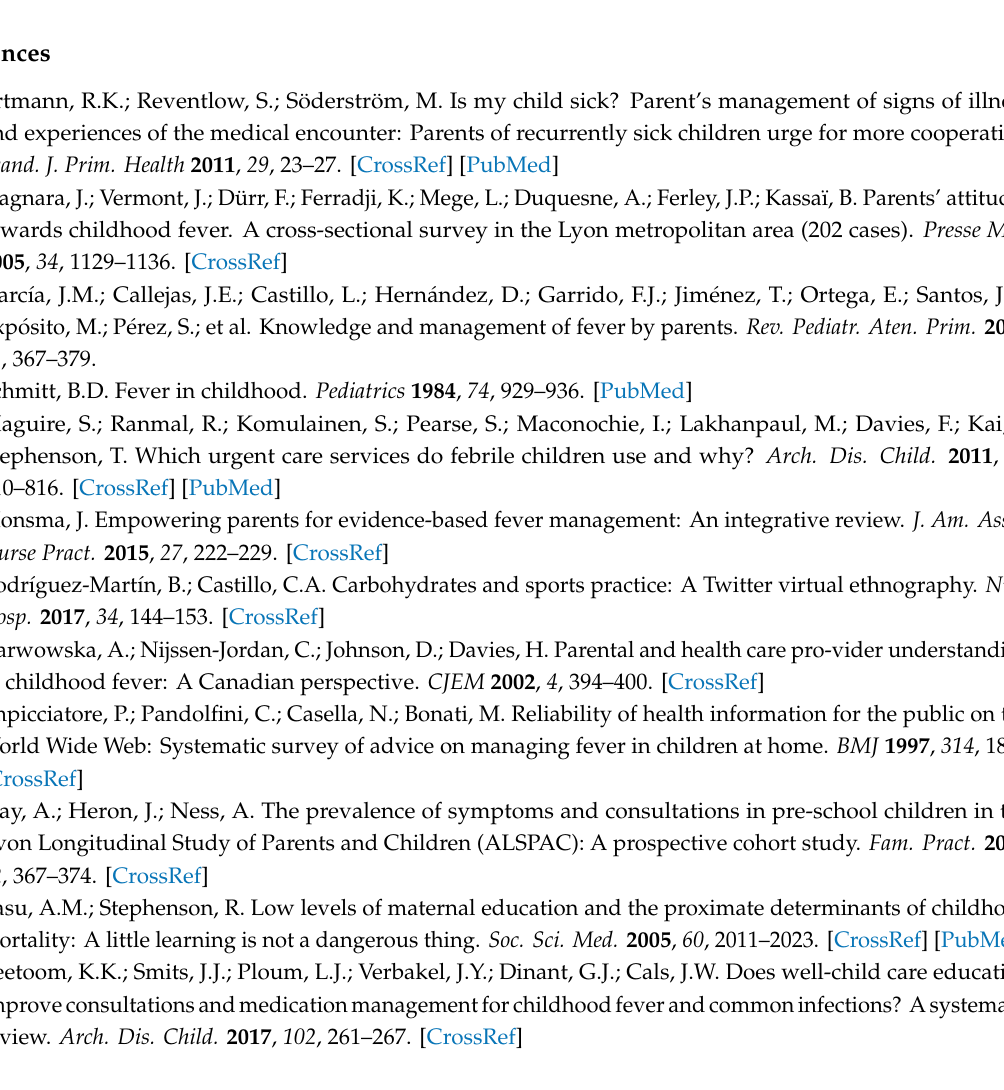
Table S1: Relationship between themes, categories, subcategories and